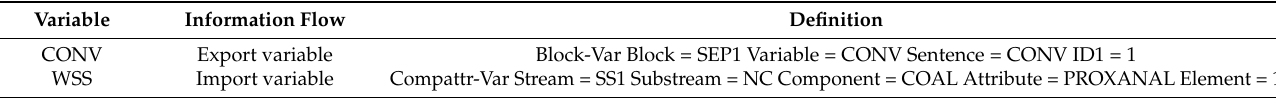
Table A4. Variables used in calculator block SS - SSW